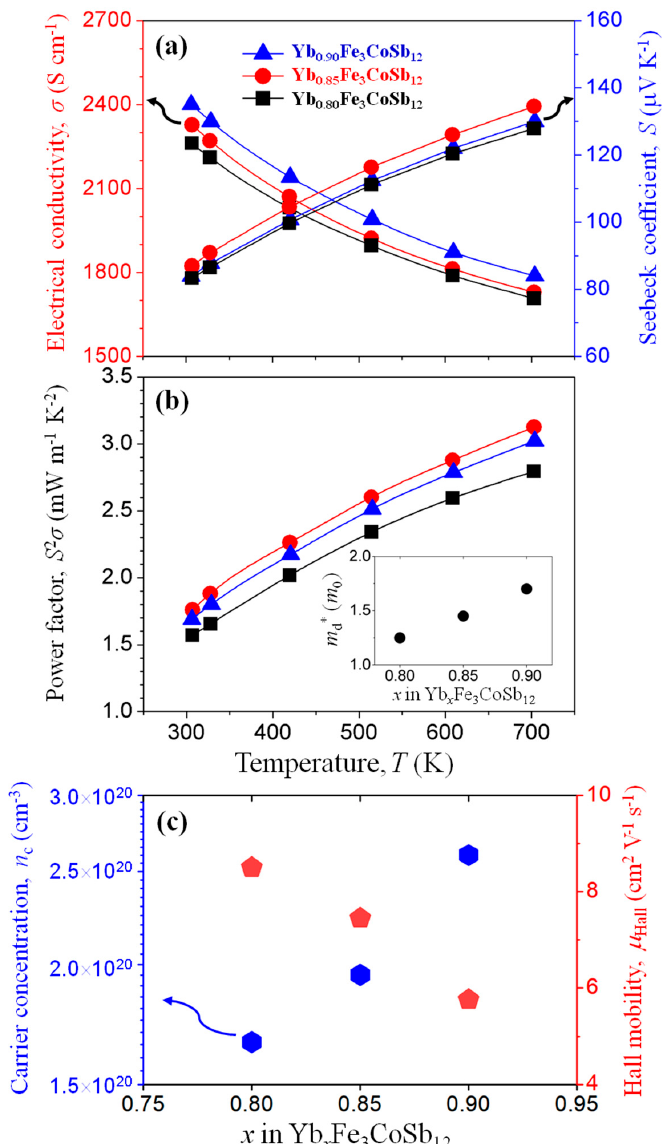
Figure 3. Temperature dependences of ( a ) electrical conductivity ( σ ), Seebeck coefficient (S) and ( b ) power factor ( σ S 2 ) for Yb x Fe 3 CoSb 12 (x = 0.80, 0.85, 0.90) bulks. Density of states effective mass ( m d *) values are shown in the inset of ( b ). ( c ) Room temperature carrier concentration ( n c ) and Hall mobility ( μ Hall ) for Yb x Fe 3 CoSb 12 (x = 0.80, 0.85, 0.90) bulks.